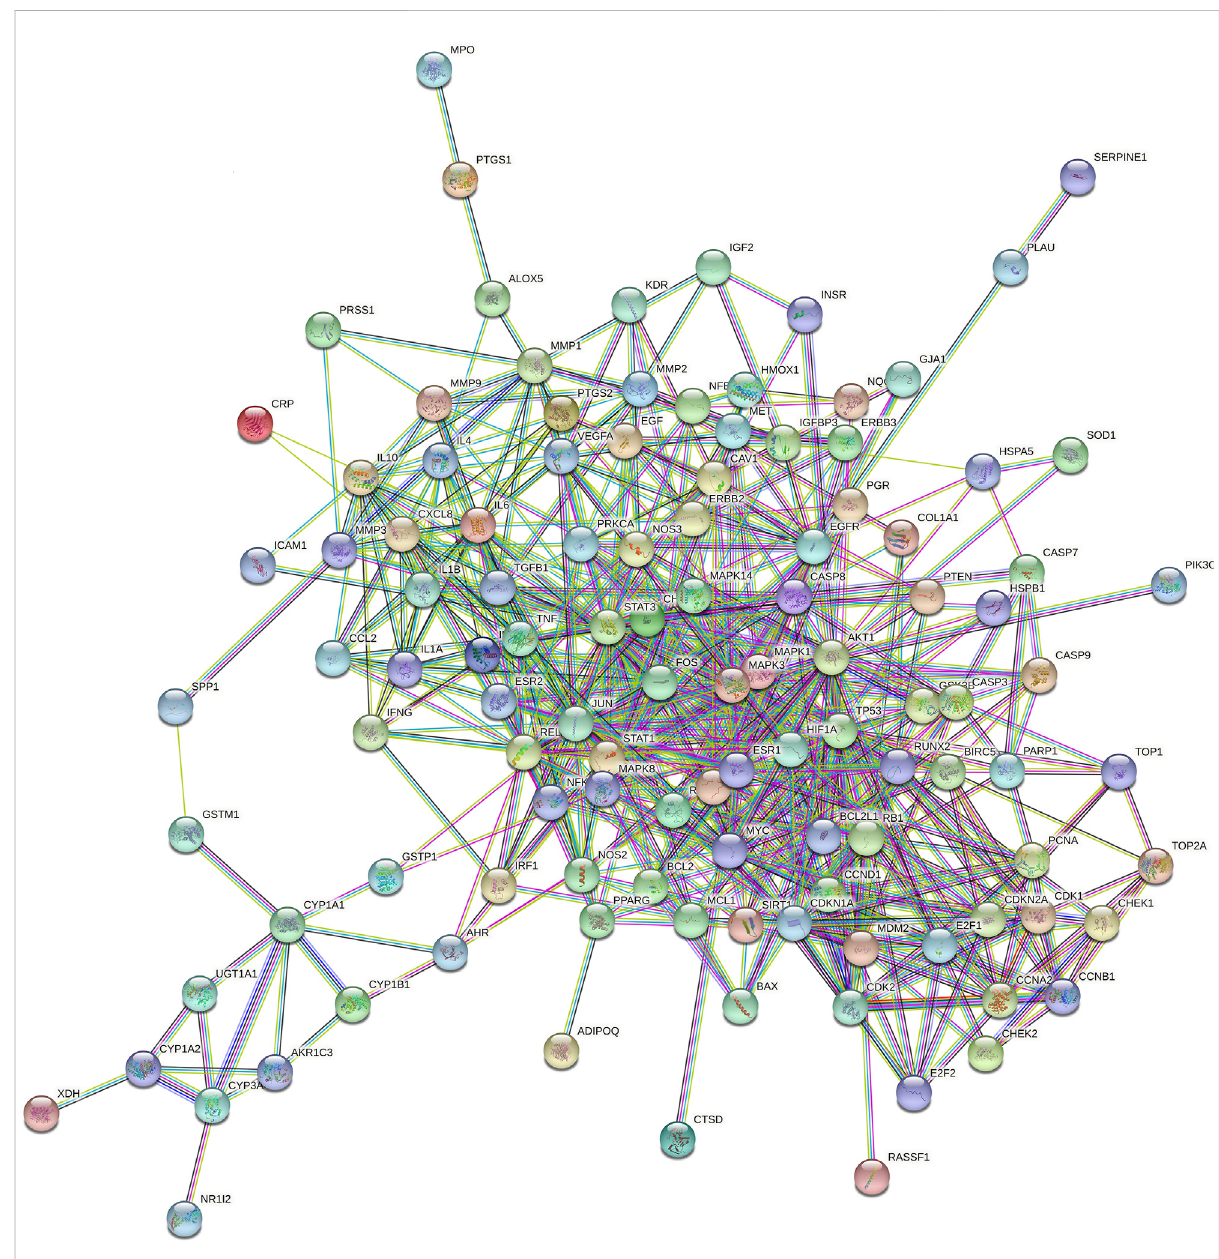
FIGURE 14 The PPI network of the intersection genes of herb targets and disease